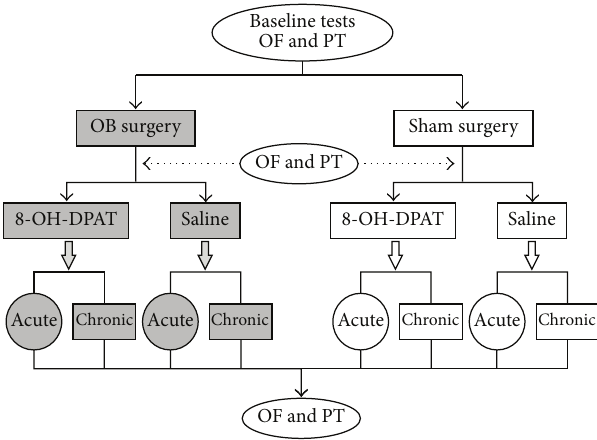
Figure 1: Schematic diagram of the experimental protocol. Baseline open-field (OF) activity and thermal pain thresholds were measured initially. Then rats were divided into two groups (OB and sham groups, receiving olfactory bulbectomy and sham surgery, resp.). Both groups were further divided into two subgroups for either saline or 8-OH-DPAT injection, which was administrated 30 min before behavioral tests (acute administration) or once daily for consecutive 14 days (chronic